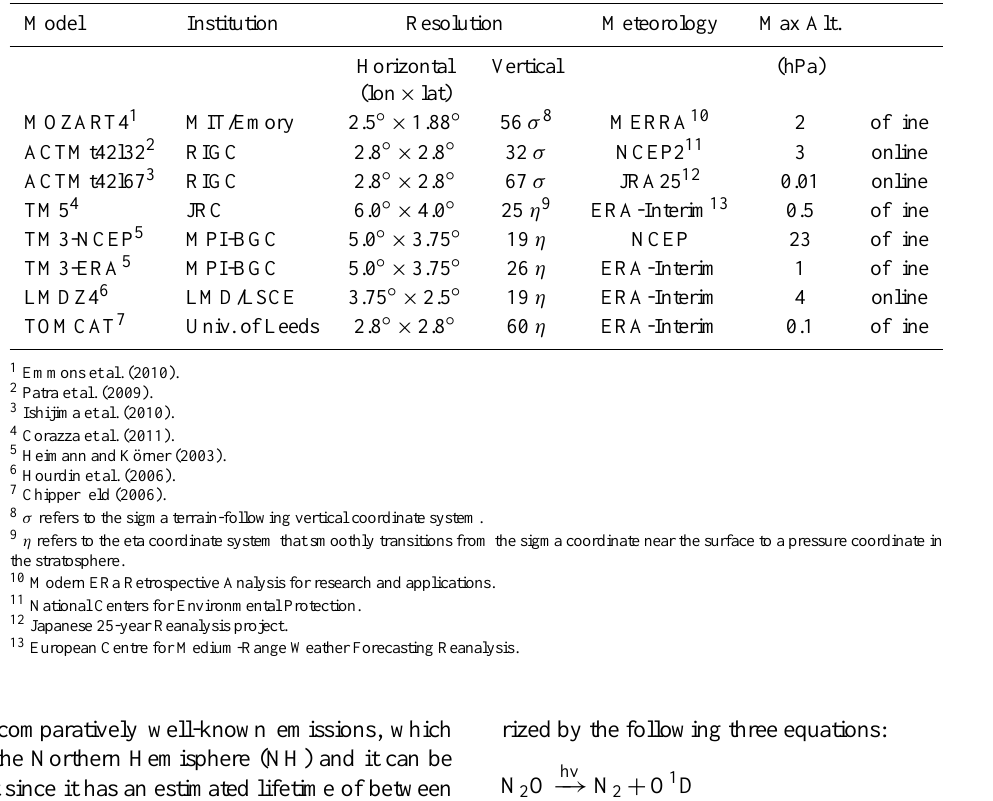
Table 1. Transport model